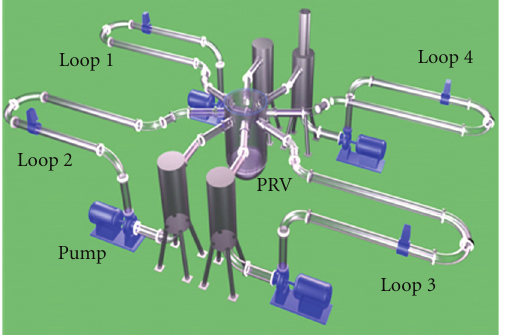
Figure 1: Scheme of ROCOM.